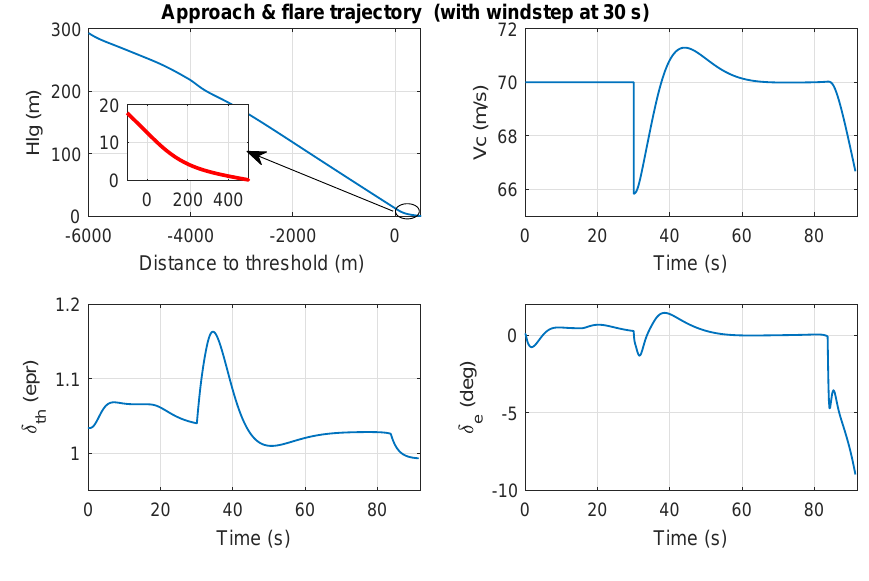
Figure 8. Final approach and flare trajectory with deterministic